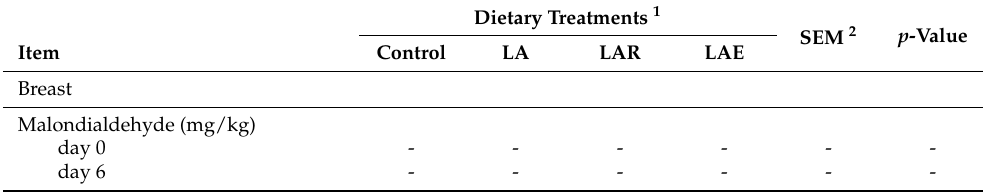
Table 6. Diterpene profile and pigments in breast and thigh meats of broilers ( n = 10).